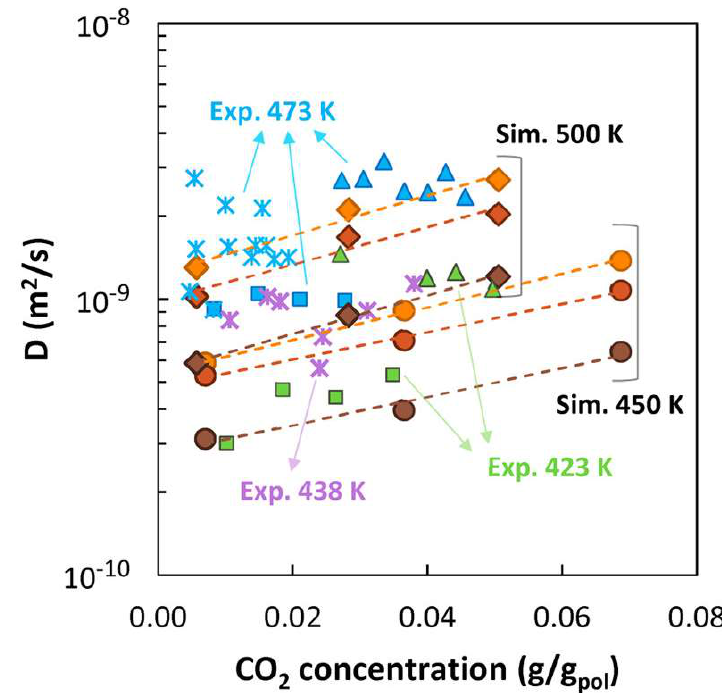
Figure 21. Simulated CO 2 diffusion coefficients in atactic polystyrene as a function of concentration at different temperatures and M w : circles, 450 K; diamonds, 500 K; orange, M w of 2100 g/mol; red, 5200 g/mol; brown, 31000 g/mol. Comparison with experimental data (squares [332], triangles [333], stars [334]; blue 473 K, green 423 K, purple 438 K). Figure reproduced from Ref. [119] under CC-BY license terms.